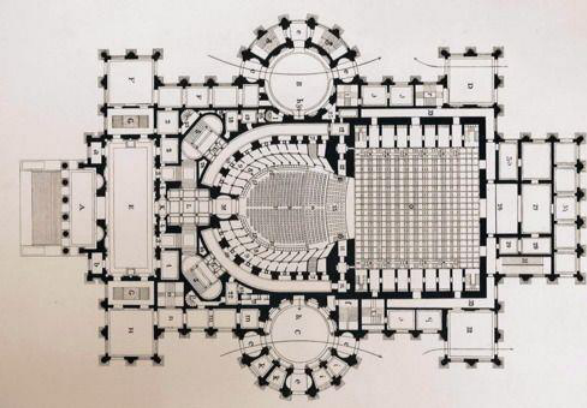
Figure 2. The plan of the Teatro Massimo